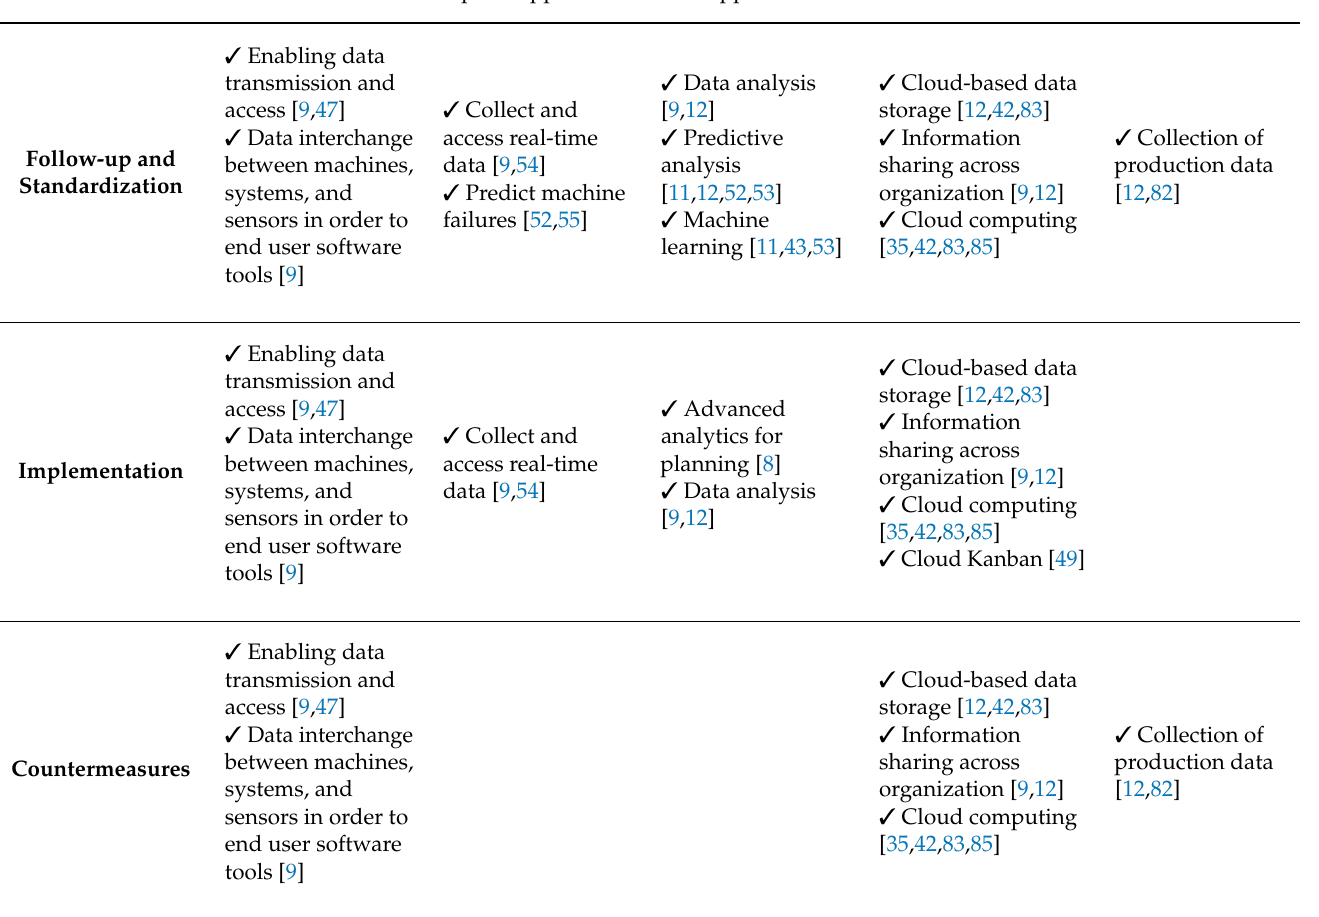
Table A1. Conceptual approaches for the application of I4.0 to